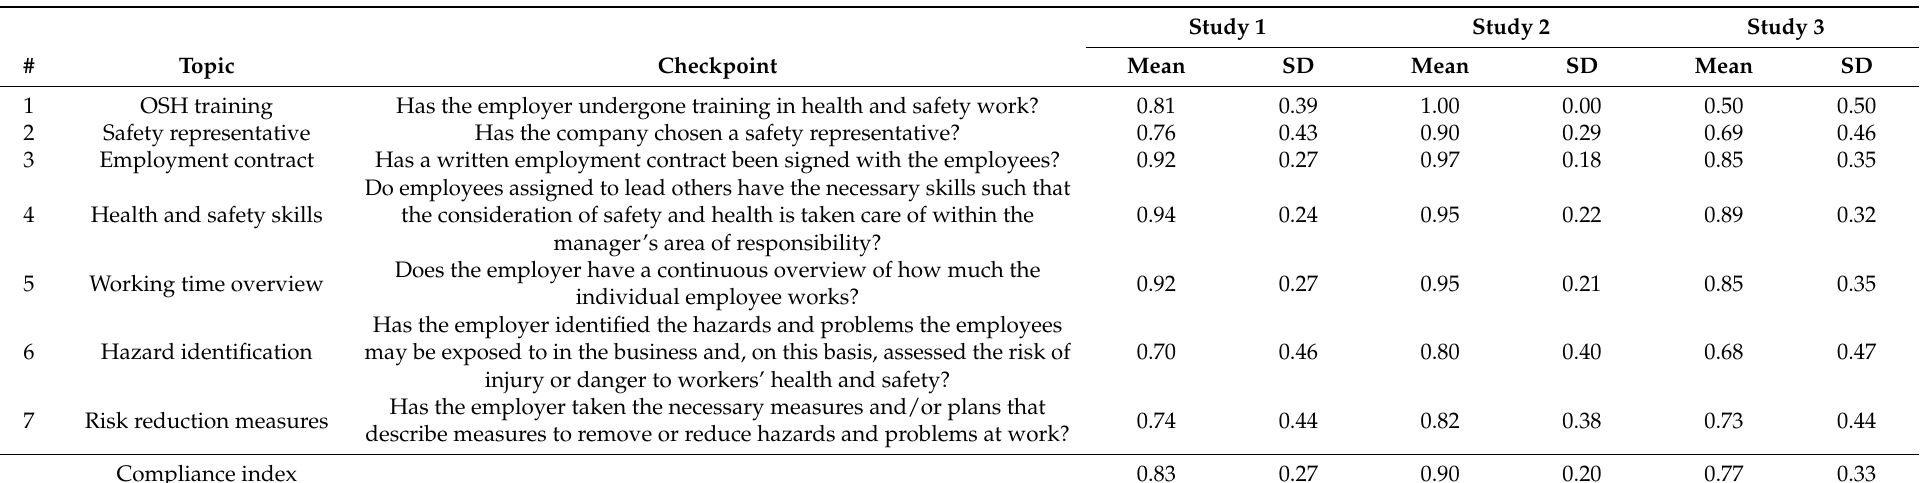
Table 2. Descriptive statistics for compliance index and checkpoints in studies 1, 2 and